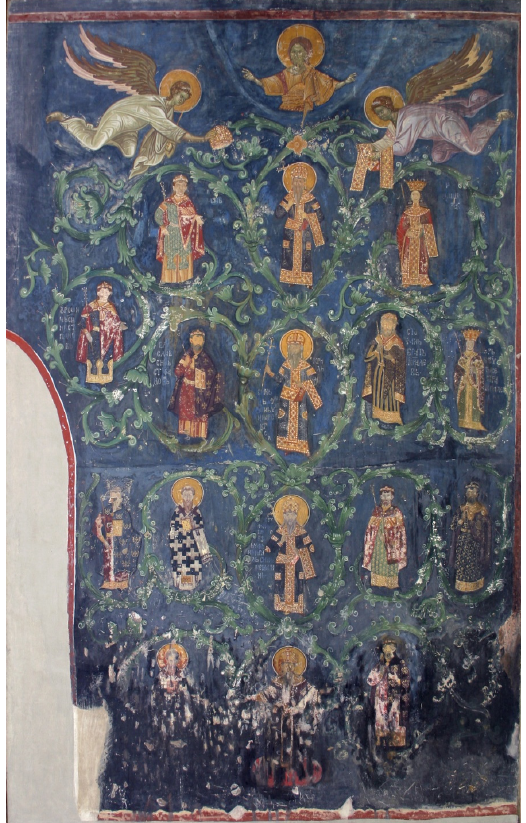
Figure 6. Nemanide’s Genealogical Tree, fresco, 1321. Church of Annunciation, Monastery of Gra č anica, south part of the eastern wall of the narthex. Courtesy Gallery of Frescoes, Belgrade.